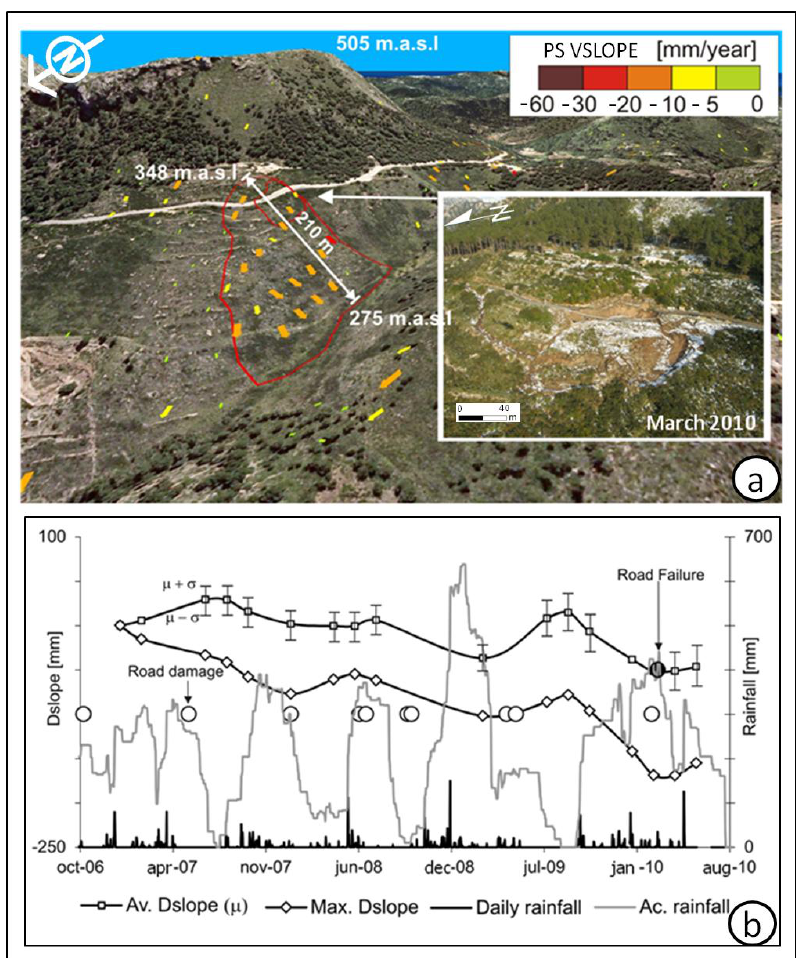
Figure 10. Mapped landslide in Estellencs area: ( a ) 3D view of enlarged landslide and photo of 8 March 2010, event; ( b ) Temporal evolution of total displacement rate projected